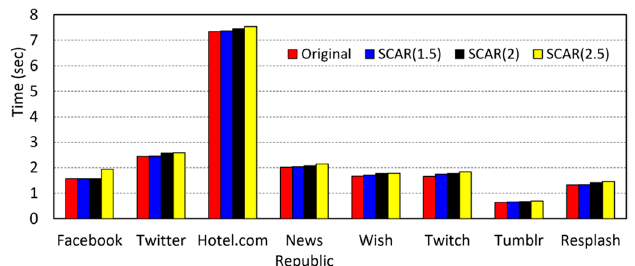
Figure 18. Window launching time in launching a scrollable window.